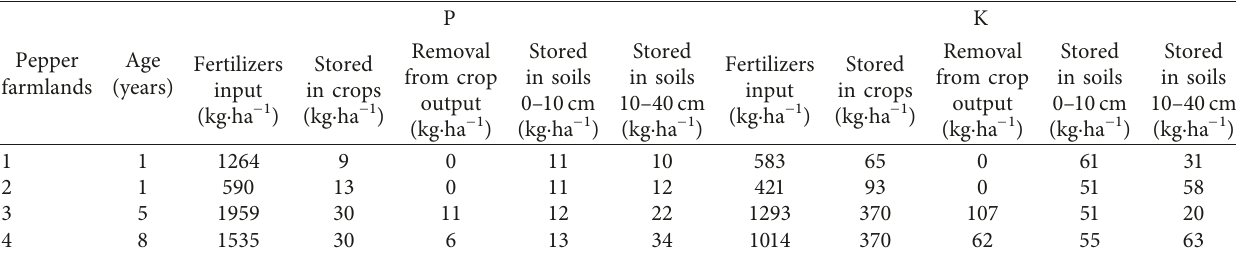
Table 8: Partial nutrient budgeting comparing fertilizer input, crop uptake, crop removal, and soils (0–40cm) for P and K in each pepper land